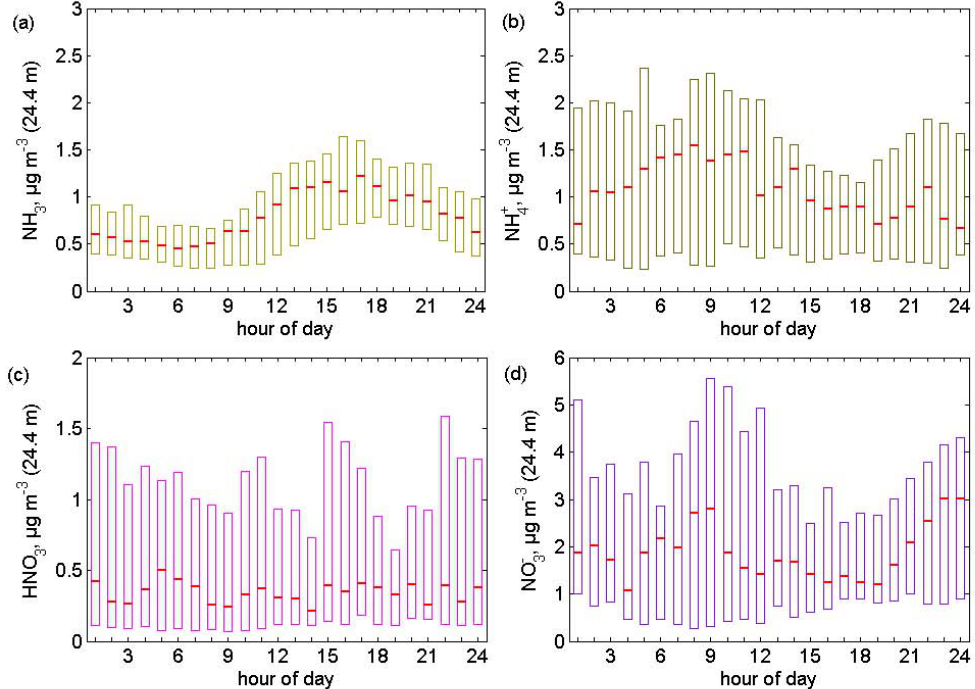
Fig. 4. Diel variation of (a) NH 3 , (b) particulate NH + lines are median concentrations, boxes denote the inter-quartile range (0.25–0.75) during NEU in Oensingen (Switzerland), 2006 (managed grassland ecosystem).